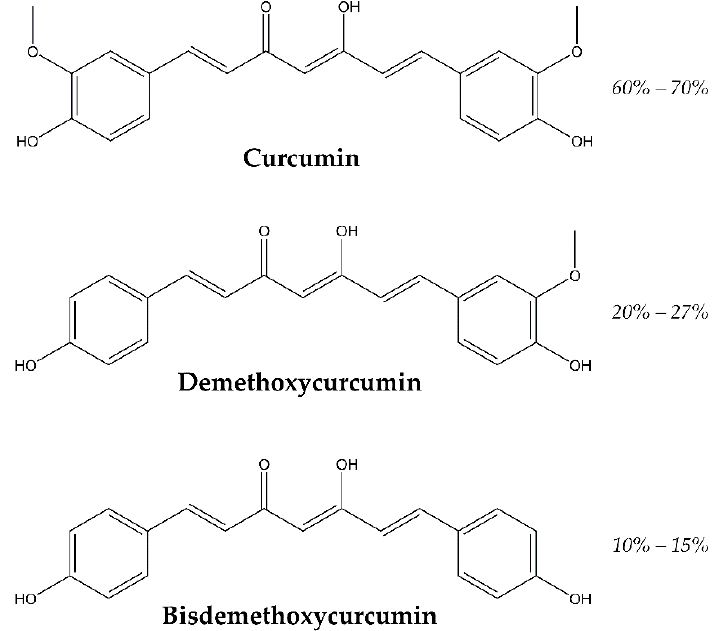
Figure 1. Structure and relative abundance of major curcuminoids.